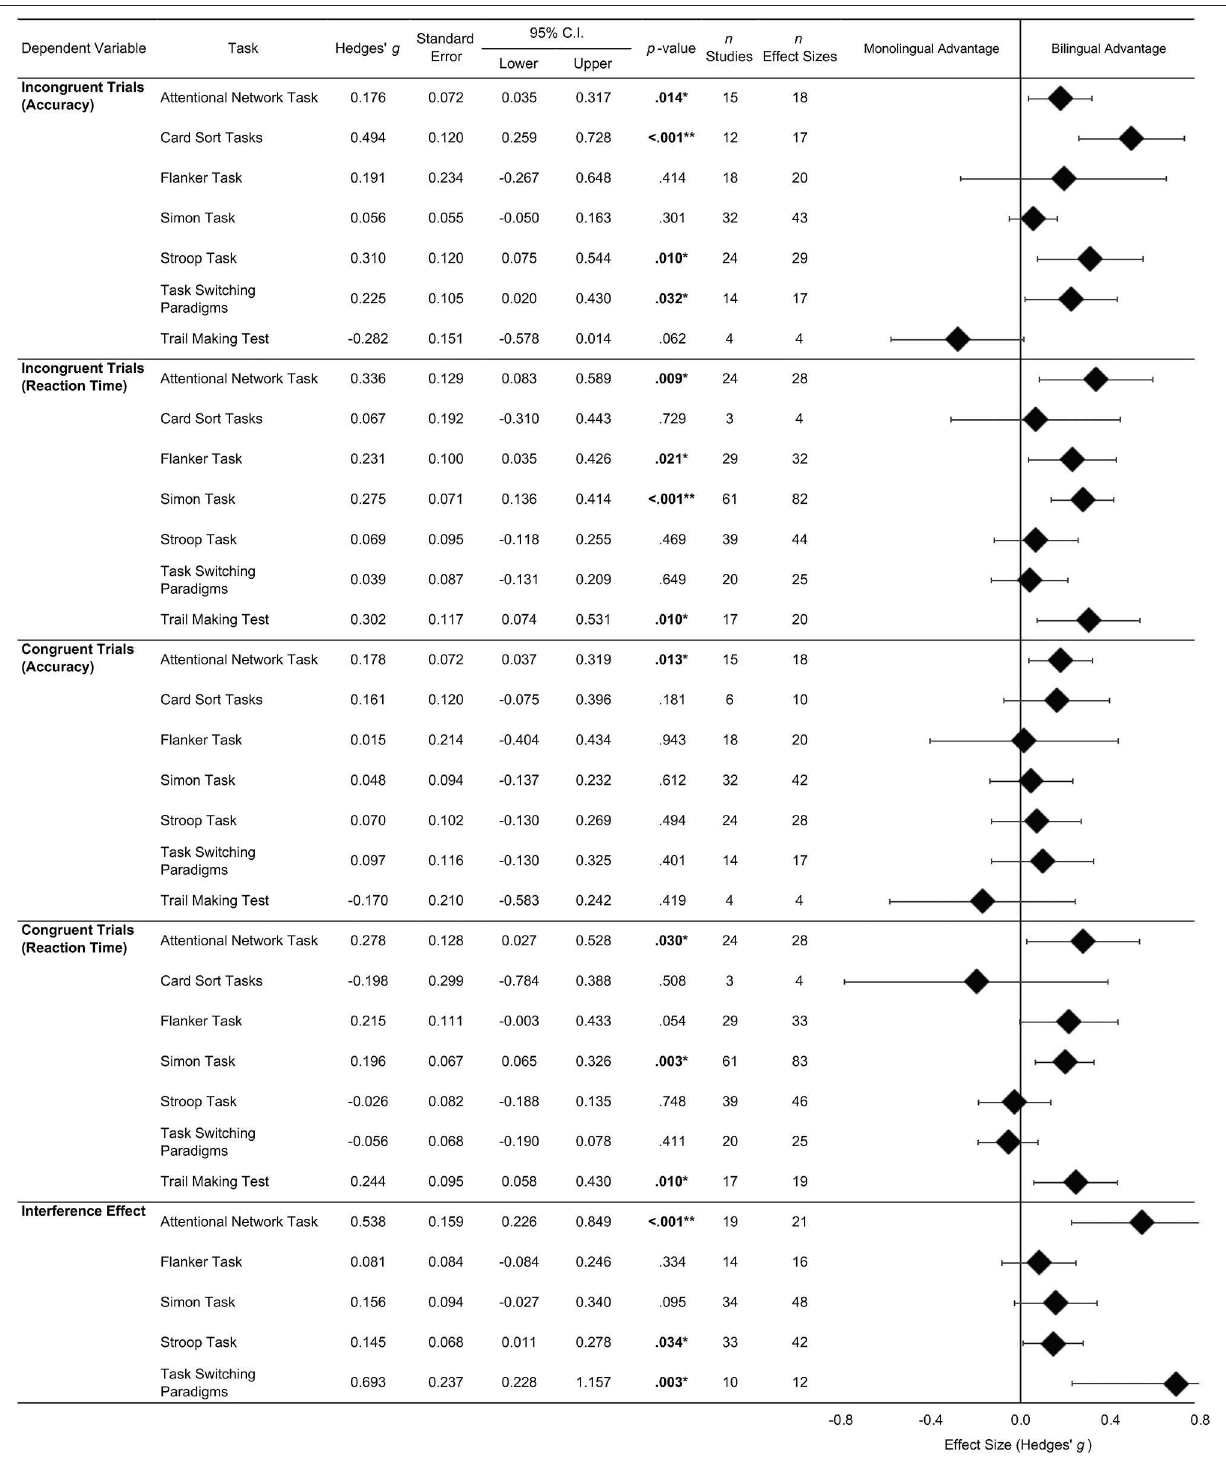
Frontiers in Psychology |